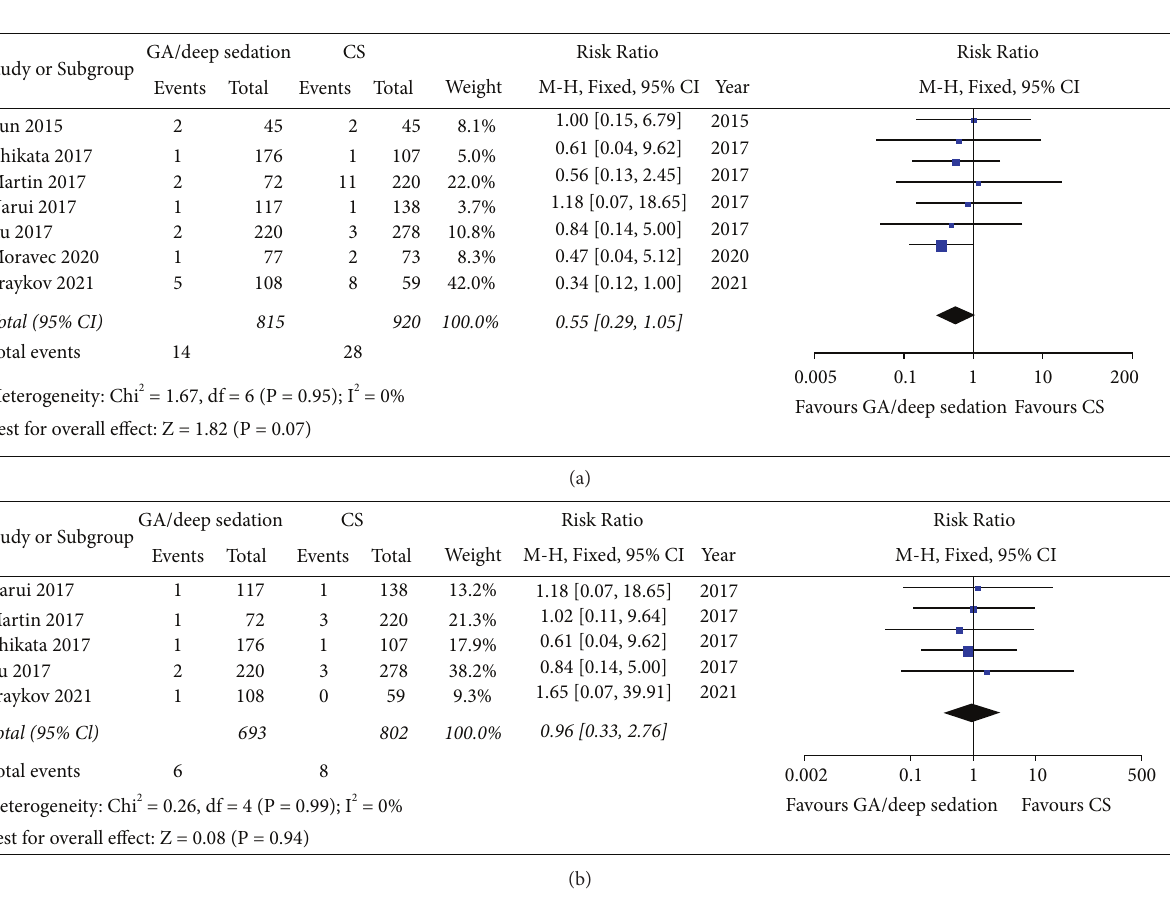
Figure 6: Forest plot comparing (a) total perioperative complications and (b) incidence of serious adverse events including atrioesophageal fistula, pericardial tamponade or pericardial effusion requiring puncture drainage between GA/deep sedation and CS in patients undergoing catheter